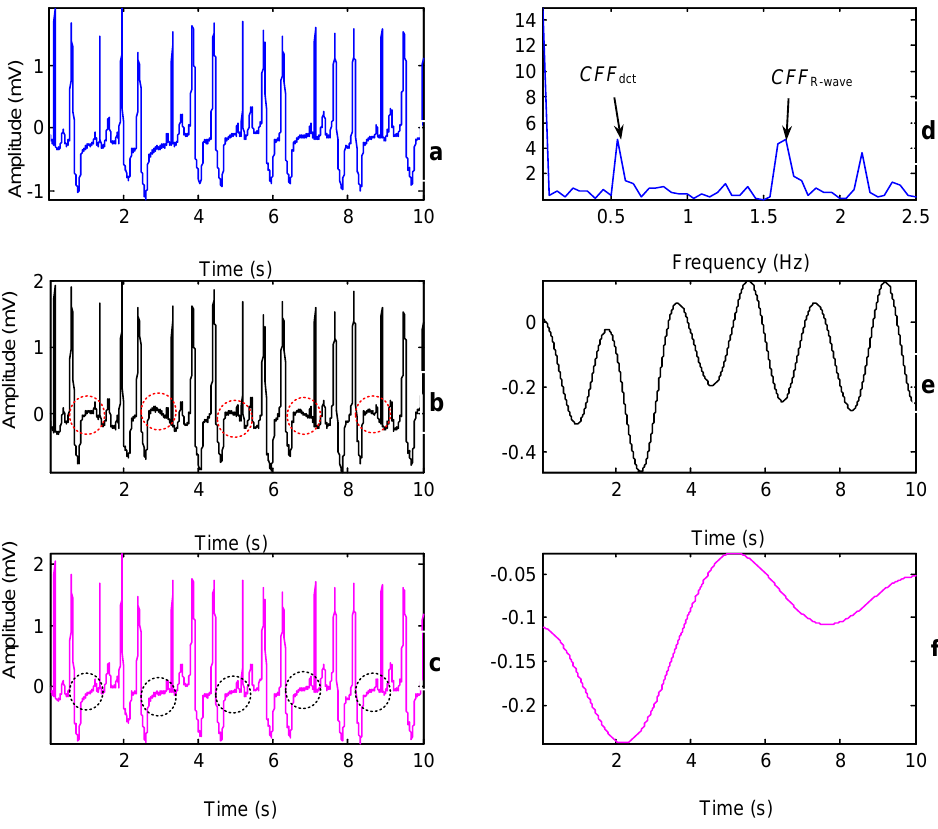
Figure 4. The impact of two CFFs when processing abnormal records (MIT-BIH record 208, lead I, 00:00–00:10). ( a ) Original ECG. ( b , c ) BW corrected ECG by using CFF R − wave and CFF dct , respec- tively. ( d ) Locations of the CFF R − wave and CFF dct in the DCT domain. ( e , f ) Estimated BWs by using CFF R − wave and CFF dct , respectively. The surrounding ellipses indicate the ST segment of the ectopic beats .